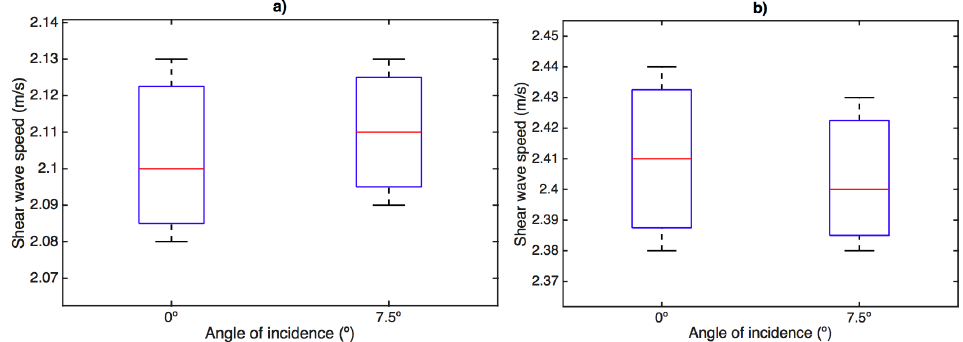
Figure 10. Box and whisker plots of shear wave speed measurements at different angles of incidence phantom–sensor. Mean (lines within boxes), interquartile range (IQR, boxes) and extreme values (whiskers) are shown; frequency: 300 Hz. ( a ) 8% gelatin; ( b ) 10% gelatin.